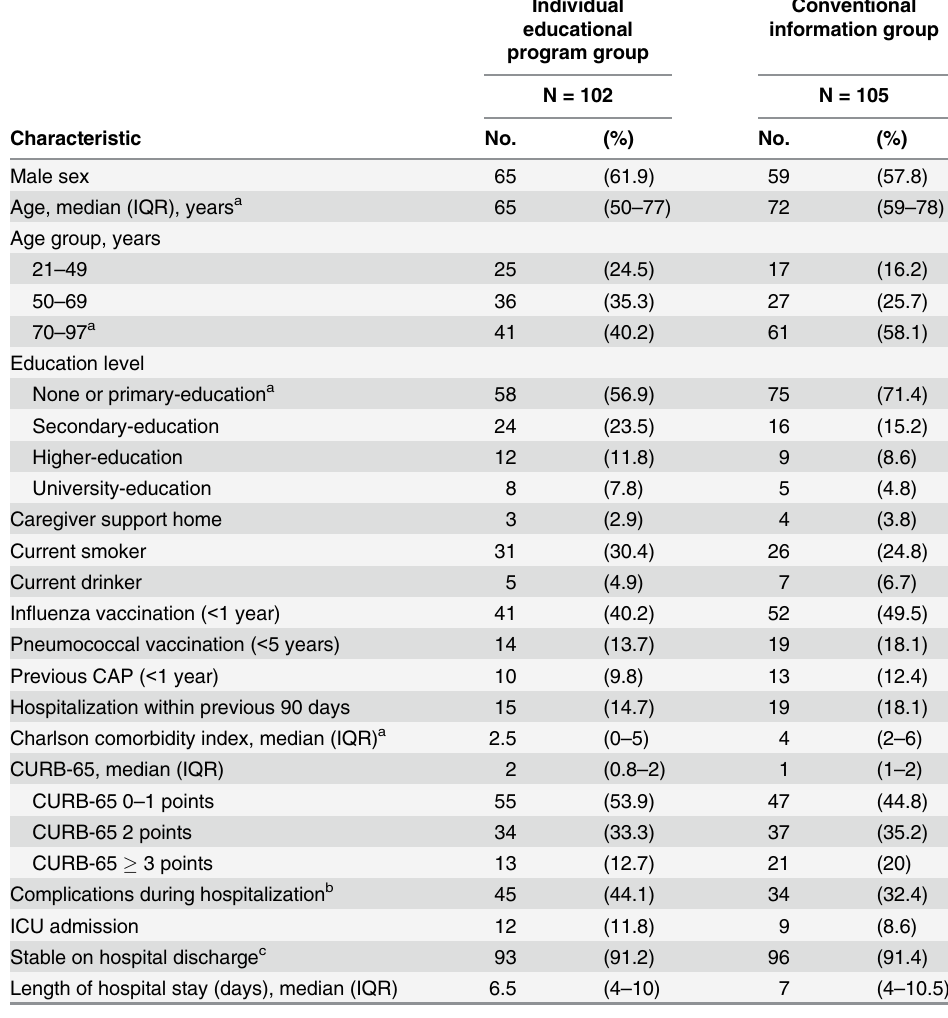
Table 1. Baseline characteristics. Abbreviations: CAP, community-acquired pneumonia; ICU, intensive care unit; IQR, interquartile range; CURB-65 (confusion, urea > 7 mmol/l, respiratory rate (cid:1) 30/min, low sys- tolic [ < 90 mm hg] or diastolic [ (cid:3) 60 mm hg] blood pressure, age (cid:1) 65